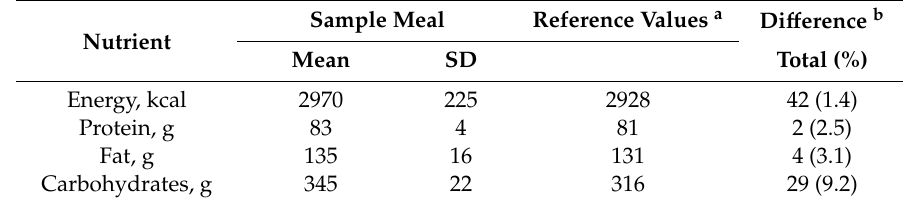
Table 5. Hypothetical energy and nutrient intake of the sample protocol and corresponding reference values ( n = 9). Sample Meal Reference Values a Di ff erence b Nutrient